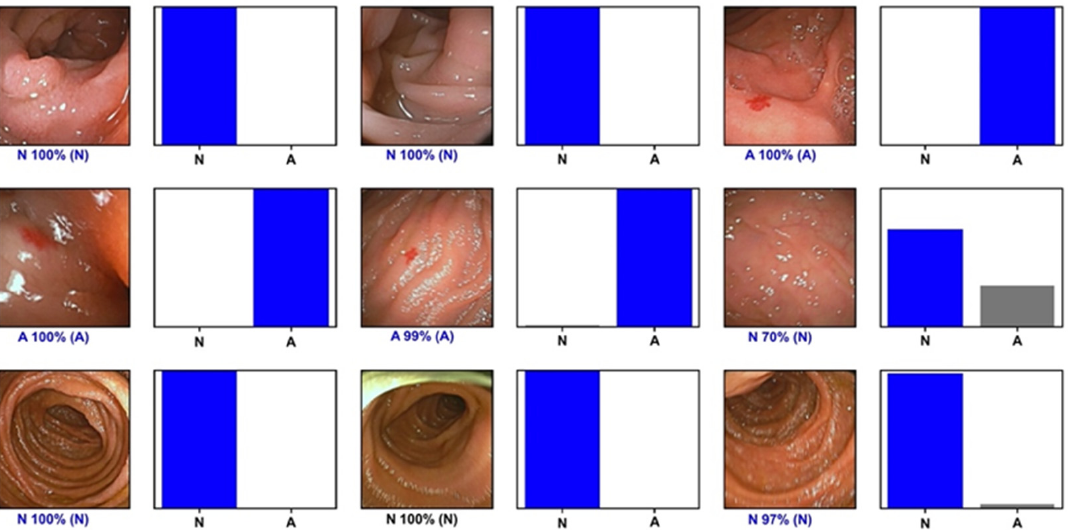
Figure 2. Output provided by the network. Each bar represents the probability calculated by the algorithm. The finding with the highest probability was outputted as the predicted classification. The blue bar represents a correct prediction. N—normal mucosa; A—Angioectasia.